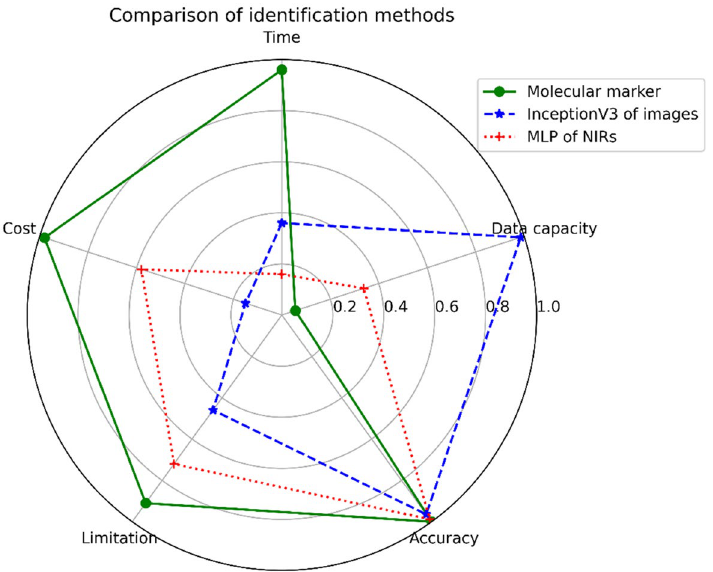
Figure 5. Radar chart of analytical costs, complexity and performance. Time: the time required for the analyses; Cost: the financial cost of completing the analyses; Limitation: the degree of limiting factors of experimental conditions; Data capacity: the amount of data obtained from the analyses; Accuracy: the accuracy of identification. The scale here represents value with 0 indicating the lowest value and 1.0 indicating the highest